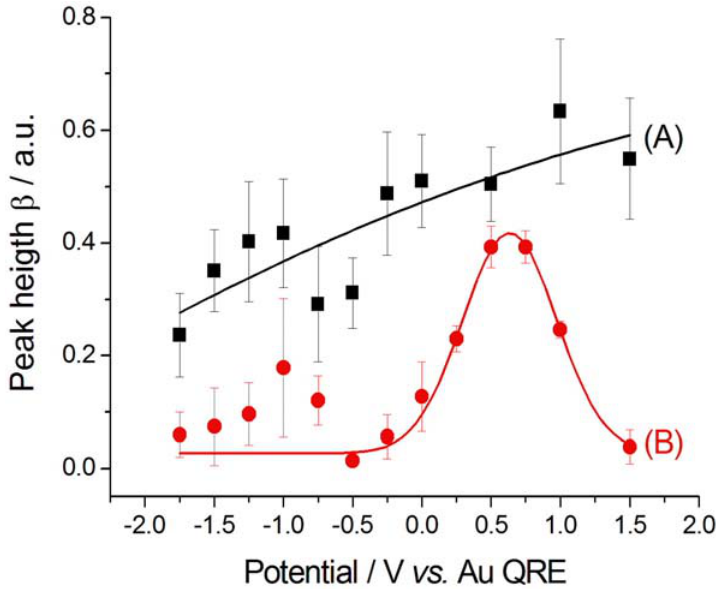
Figure 8. Peak height  corresponding to nitrile adsorbed at Au in contact with [BMP][TFSA] containing 1 mM CTDB. ( A ) Cathodic-going scan, SFG spectra (see Figure 2); ( B ) Anodic-going scan, DFG spectra (see Figure 3). The error bars correspond to estimated 95% confidence